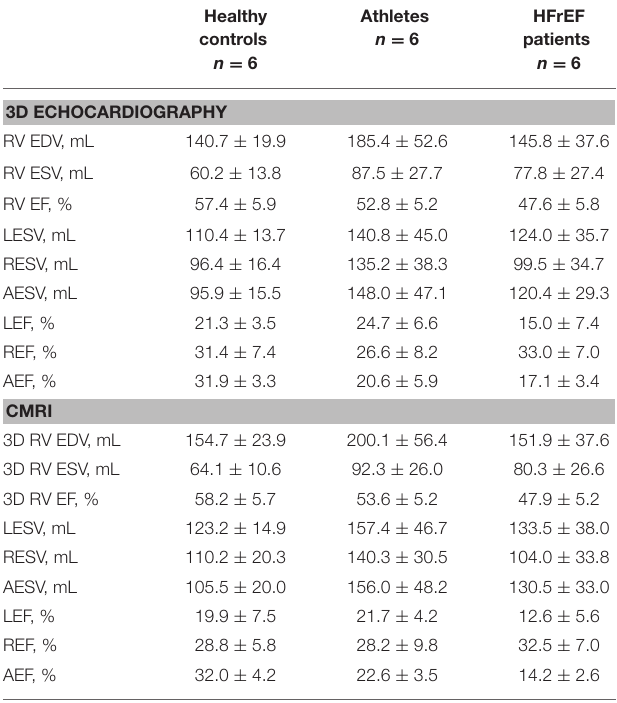
TABLE 4 | Summary of the 3D echocardiography- and cardiac magnetic resonance imaging-derived